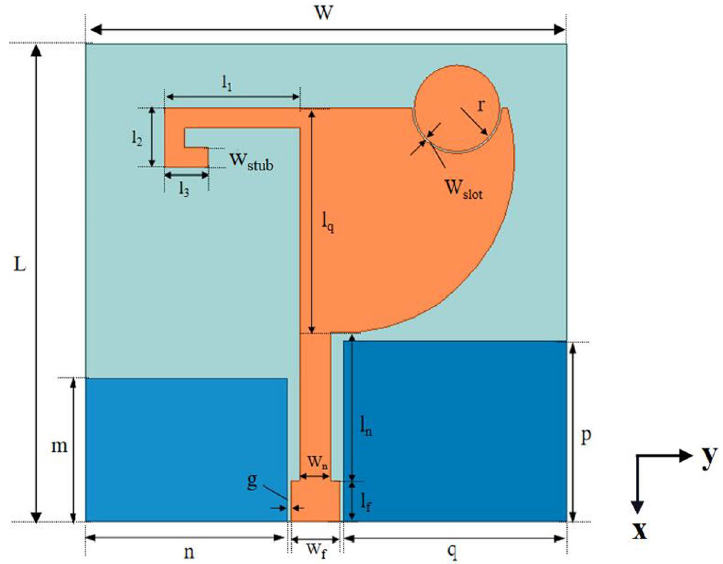
Fig. 1 Top view of the designed circular polarization antenna